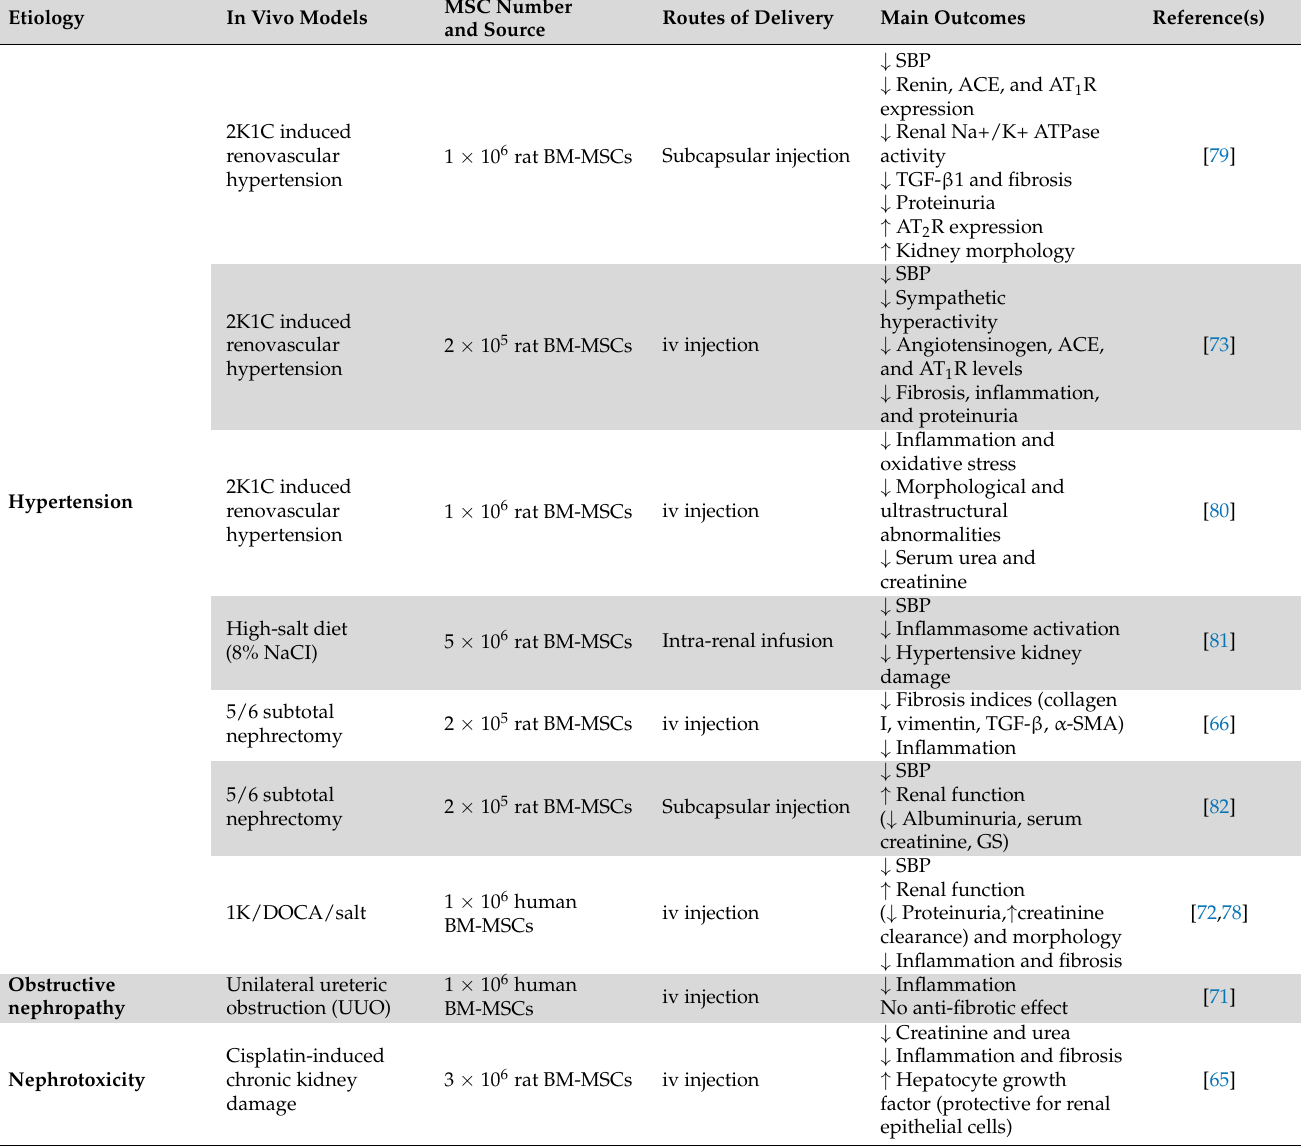
Table 2. Examples of preclinical studies evaluating the therapeutic effects of BM-MSCs in models of chronic kidney diseases due to various